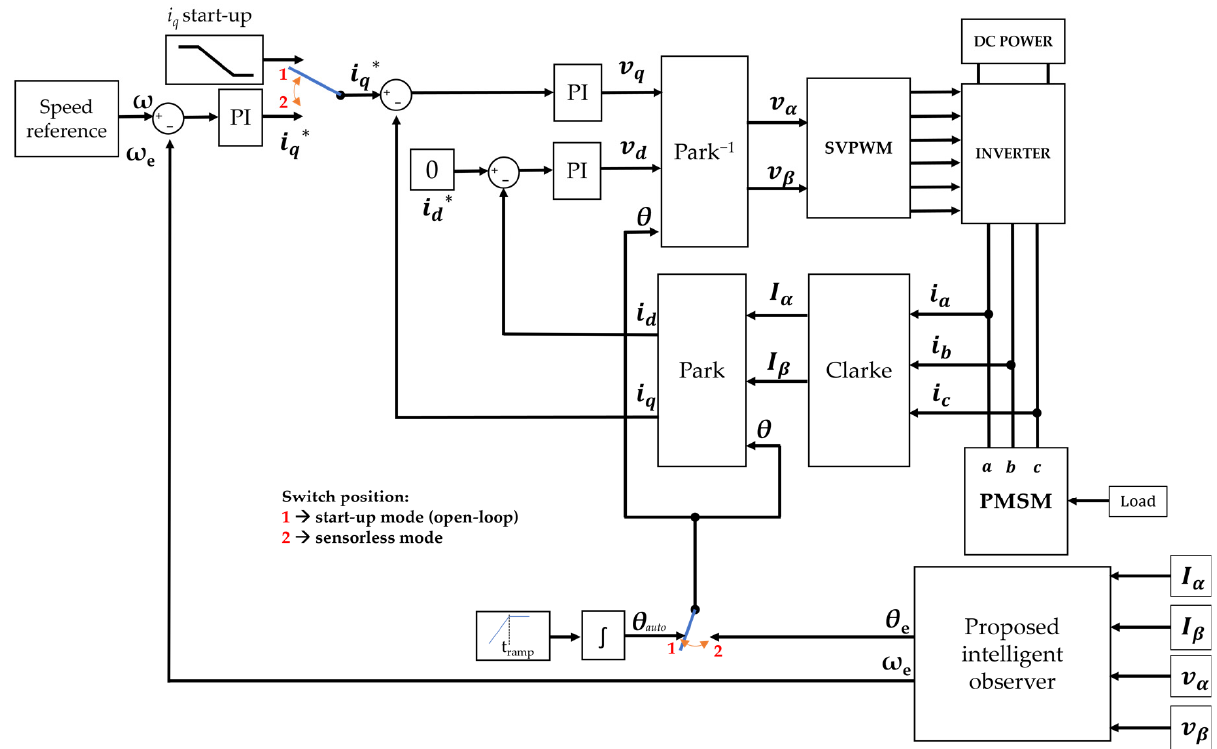
Figure 3. Sensorless PMSM-FOC control scheme process using a proposed intelligent observer.